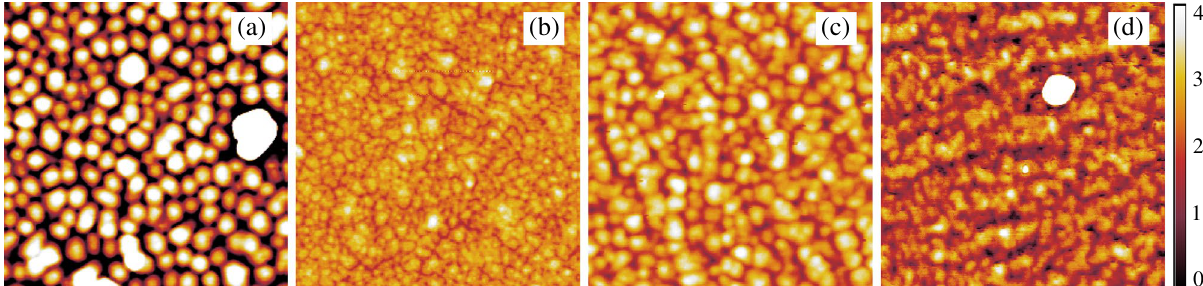
Figure 2. The AFM images of samples deposited at various laser frequencies: f = 1 Hz ( a ), 2 Hz ( b ), 3 Hz ( c ), and 5 Hz ( d ). Lateral size of images is 1 µ m and the color bar denotes height in nm same for all growth and the fit was a bit worse compared to the other samples. Panel (b) displays the time dependence of the β f = 2 Hz. relative widths p j . The time dependence of the widths obeys the t j scaling except for the sample with In (c) we plot the dependence of the growth rate r on the laser frequency f . As expected, r increases linearly with f . Panels (d) and (e) display the relative width p 20 of the 20th profile and the slope β . Both of them decrease with